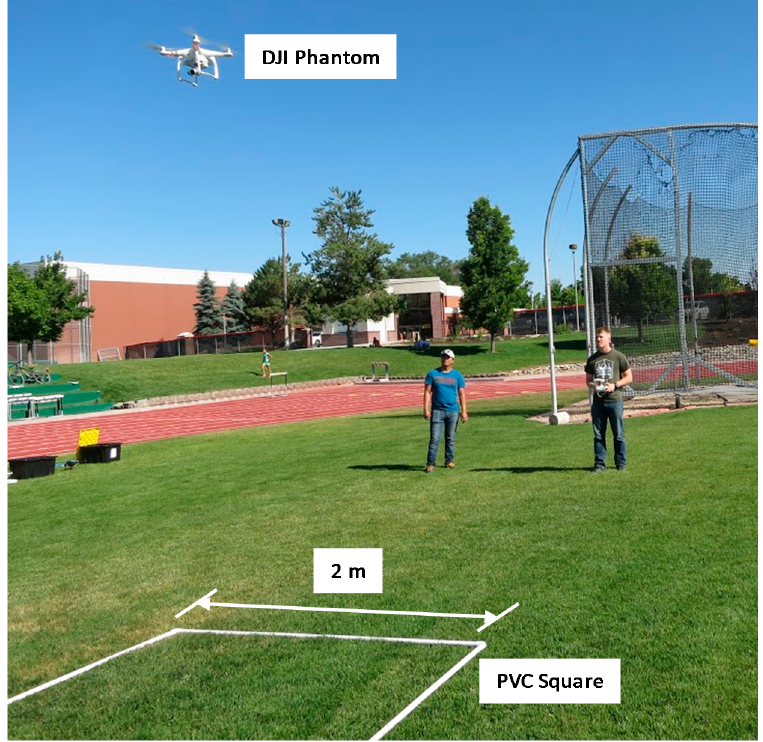
Figure 3. Hovering test for the DJI Phantom.